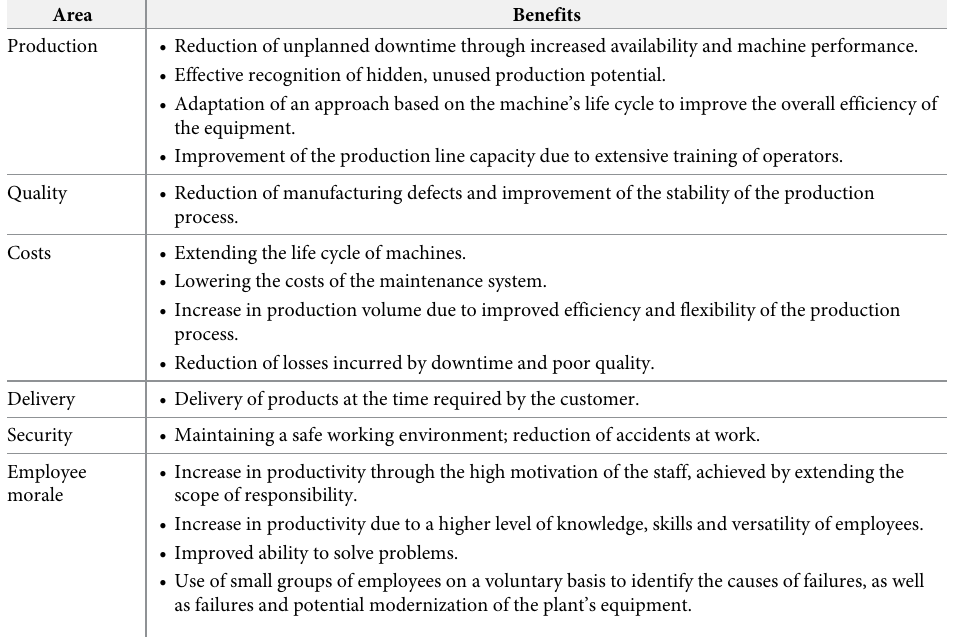
Table 2. Benefits of using the TPM method [30].